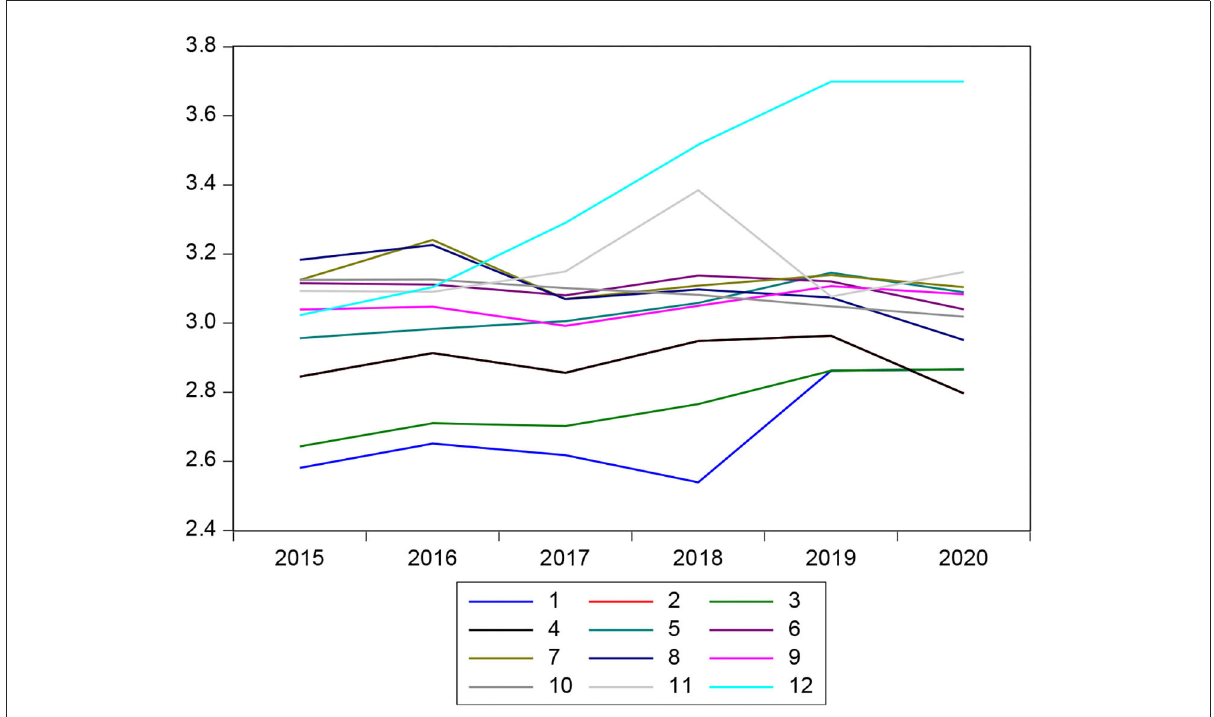
FIGURE3 Behavior of the delinquency rate.